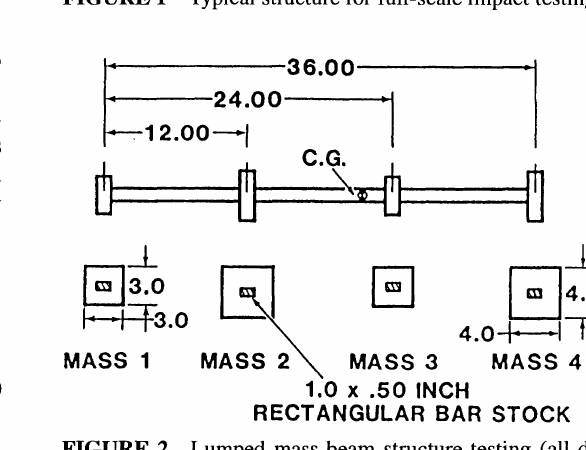
FIGURE 1 Typical structure for full-scale impact testing.